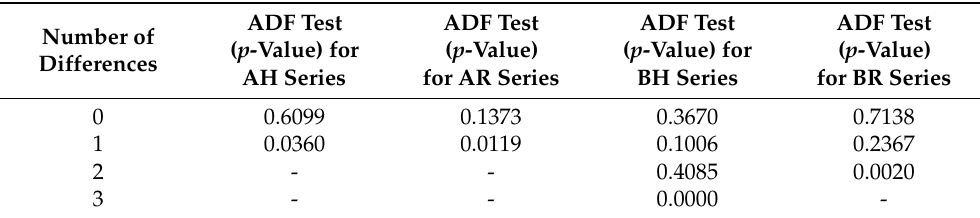
Table 3. The p -values obtained after ADF test, by using square root differences, for basil heigh time series data.